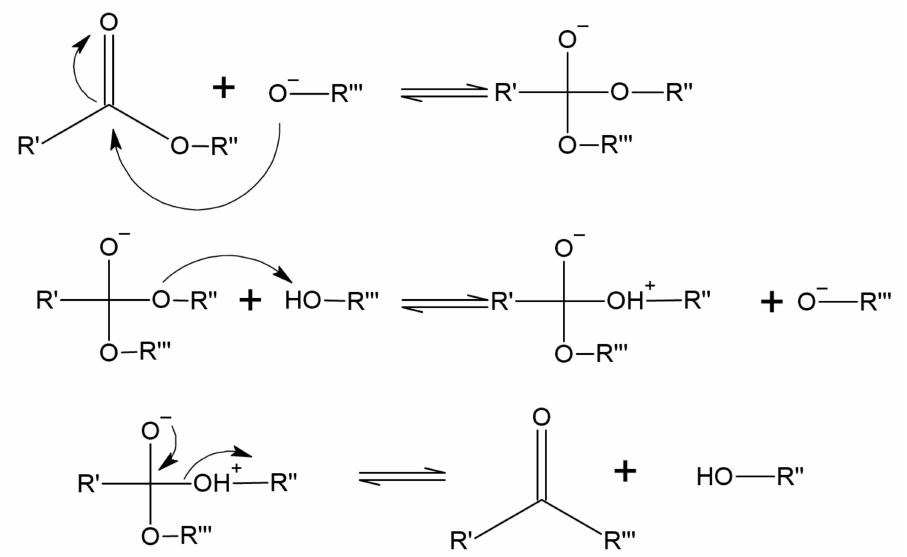
Figure 2. Transesterification reaction of triacylglycerides with methanol in an alkaline medium to produce monoalkyl fatty-acid esters (adapted from Solomons et al. (2014) [35]). This process was repeated consecutively until the water reached a neutral pH. After removing the water, the biodiesel was filtered on filter paper and added with 5 g of anhydrous sodium sulfate, in which, when hydrated, it is able to remove any traces of water present in the medium. Subsequently, a new filtration on filter paper was carried out to remove the excess sodium sulfate formed. Thus, the biodiesel from purified frying oil was obtained (Figure